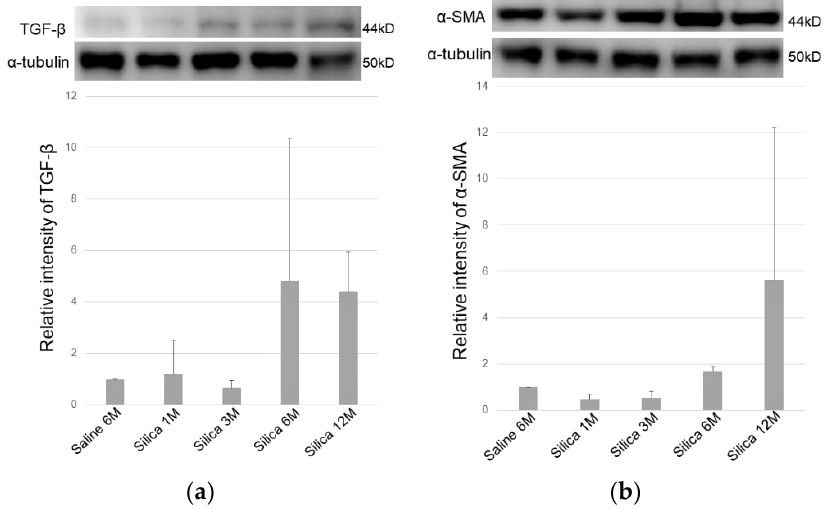
Figure 7. ( a ) Protein expression of TGF- β and ( b ) α -smooth muscle actin examined by Western blotting analysis. Increased TGF- β and α -smooth muscle actin positivity is shown in the silica treated lung tissues. M: month. All data are expressed as mean ± SD.